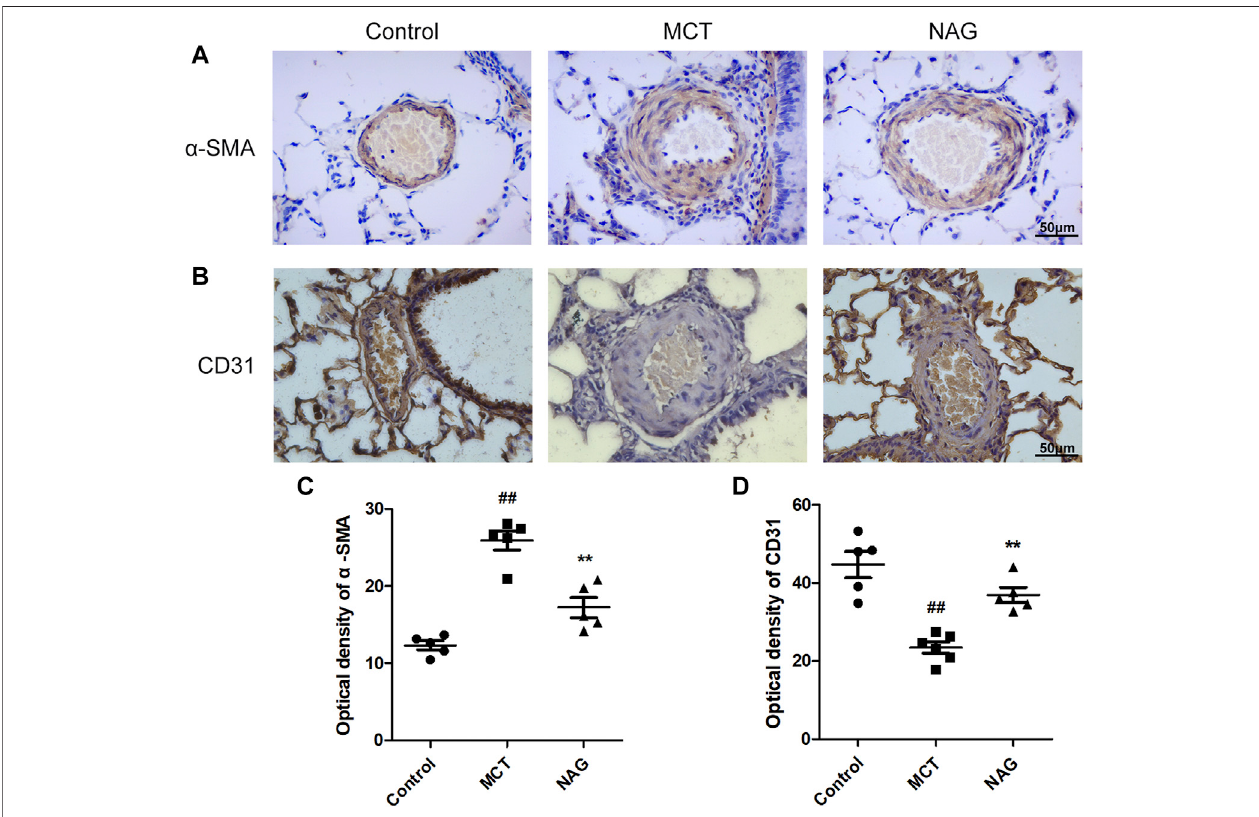
FIGURE 3 | Effects of naringin on expressions of α -SMA and CD31 in the MCT-induced PAH. The expressions of α -SMA (A) and CD31 (B) in lungs in immunohistochemistry staining. Quanti fi cations of α -SMA optical density (C) and CD31 optical density (D) . Magni fi cation × 400, scale bars (cid:1) 50 μ m ## p < 0.01 vs. control; ** p < 0.01 vs. MCT. n (cid:1)